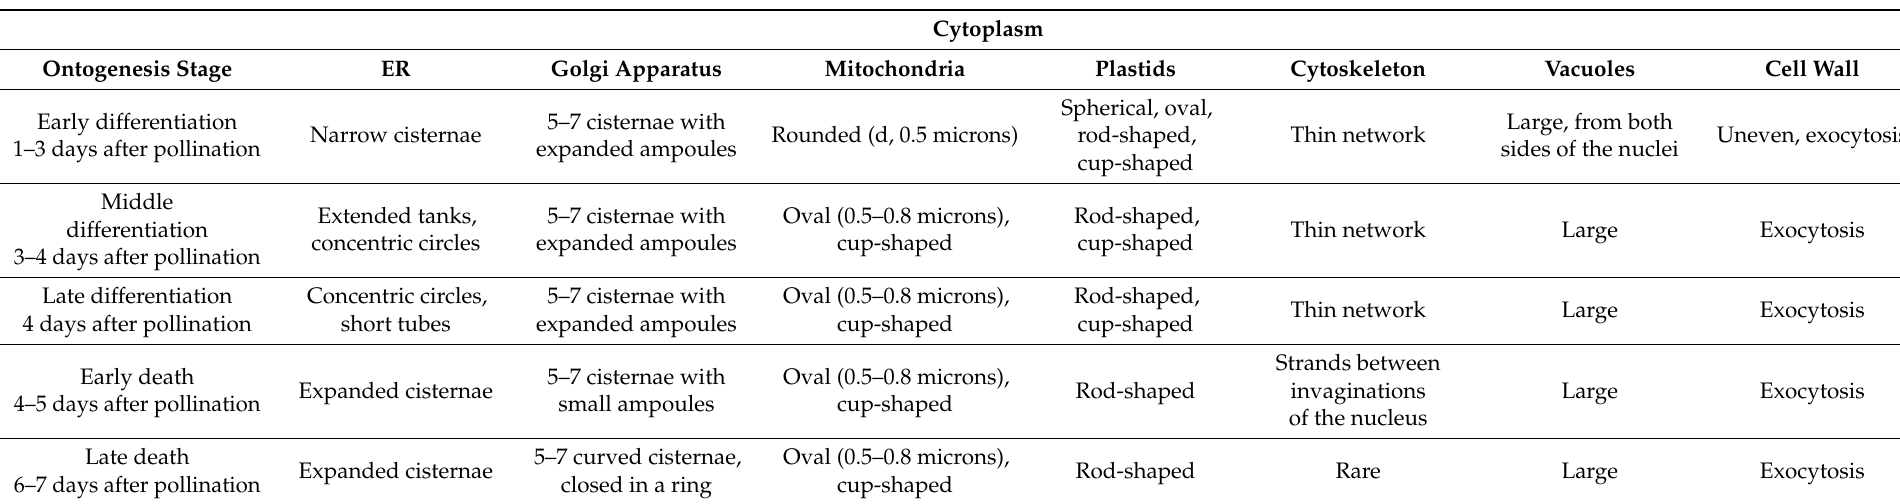
Table 6. The characteristics of the antipodal cell cytoplasm during differentiation and